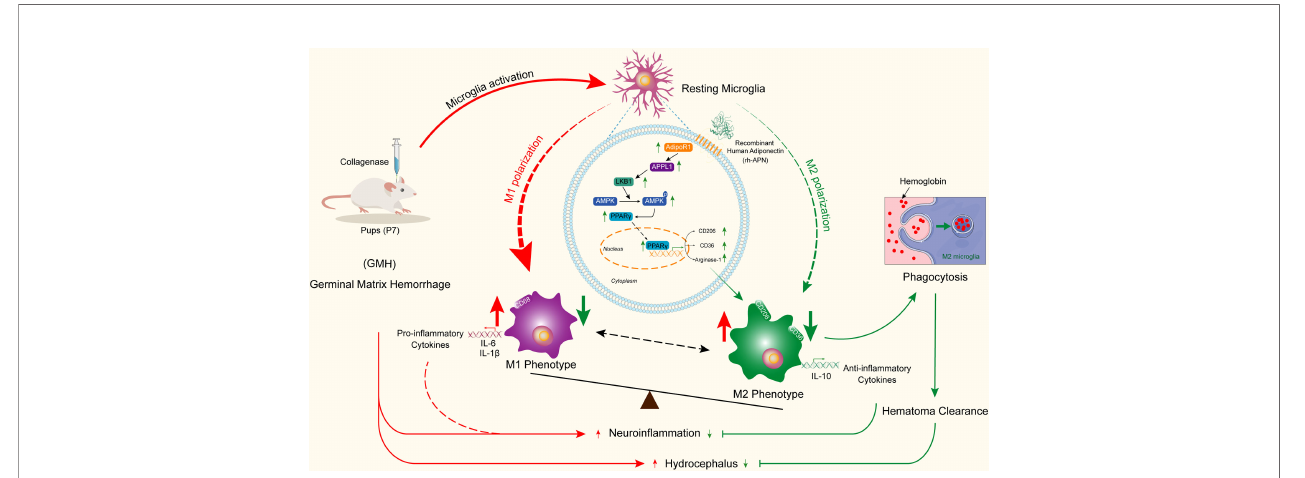
FIGURE 9 | Adiponectin regulates microglia polarization and exerts neuroprotective effects via AdipoR1/APPL1/AMPK/PPAR g